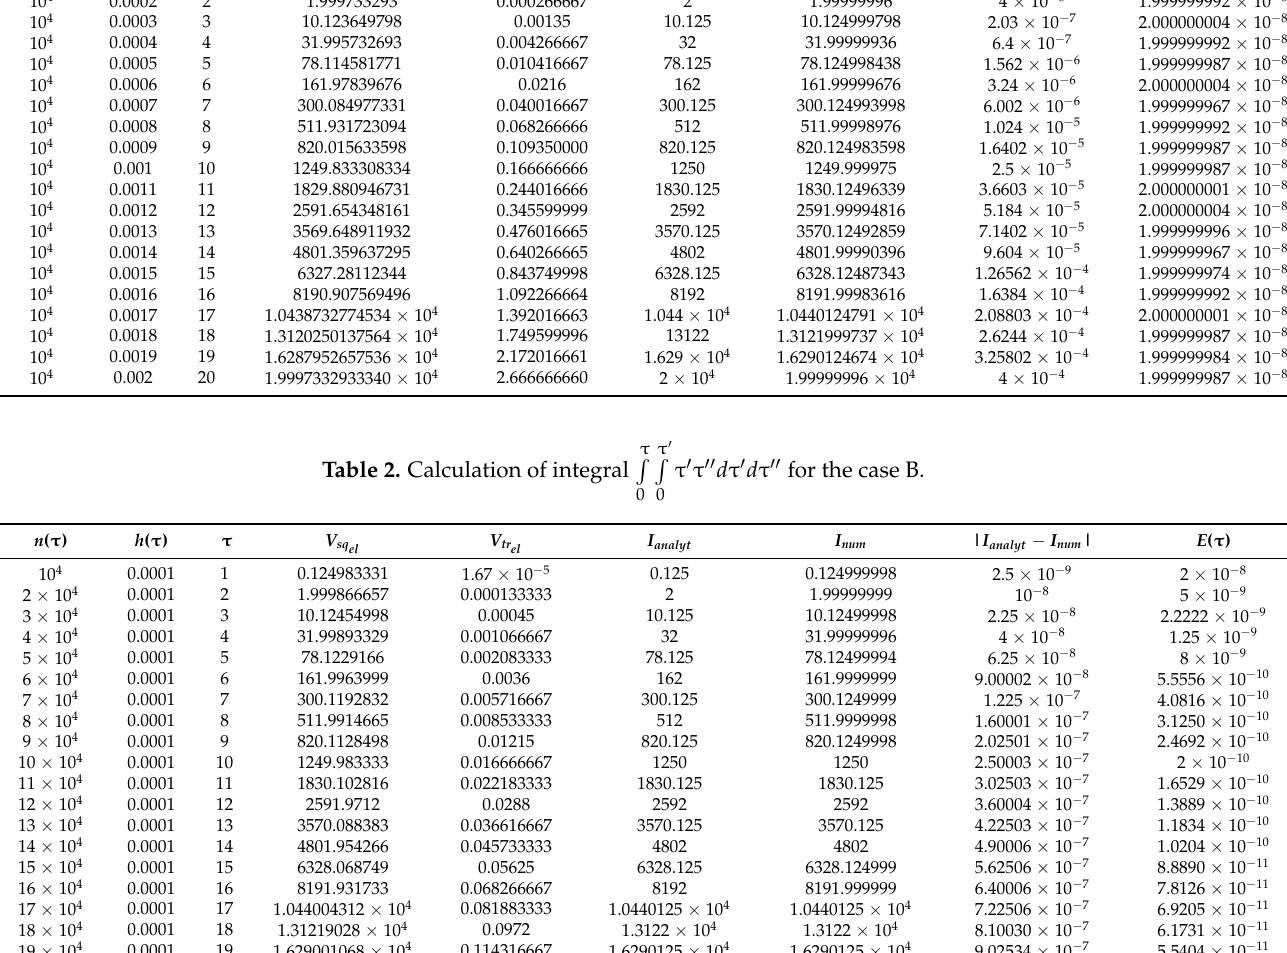
integration by Formula (15) of the case of A, (16) of the case of B, (17) of the cases of C1 for increasing function n ( τ ) and C2 for decreasing n ( τ ). τ (cid:82) Table 1. Calculation of integral